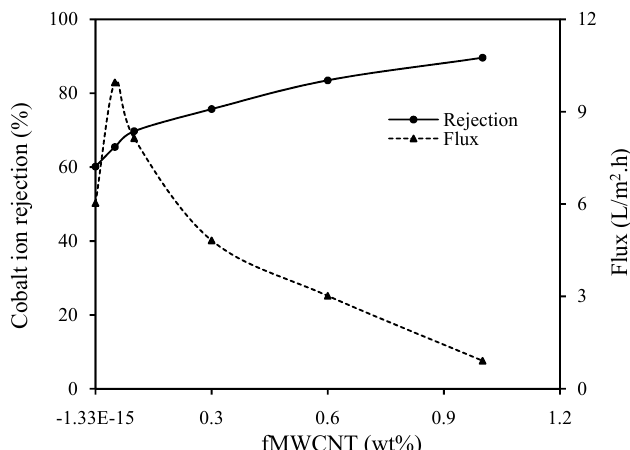
Fig. 6. Permeate flux and cobalt ion rejection percentage by the MMM (containing 22 wt. % PES) versus the different amount of fMWCNTs (20 bar, 40 L/h, 20 ppm Co(NO 3 ) 2 , pH=5.5 ± 0.1, 90 min)